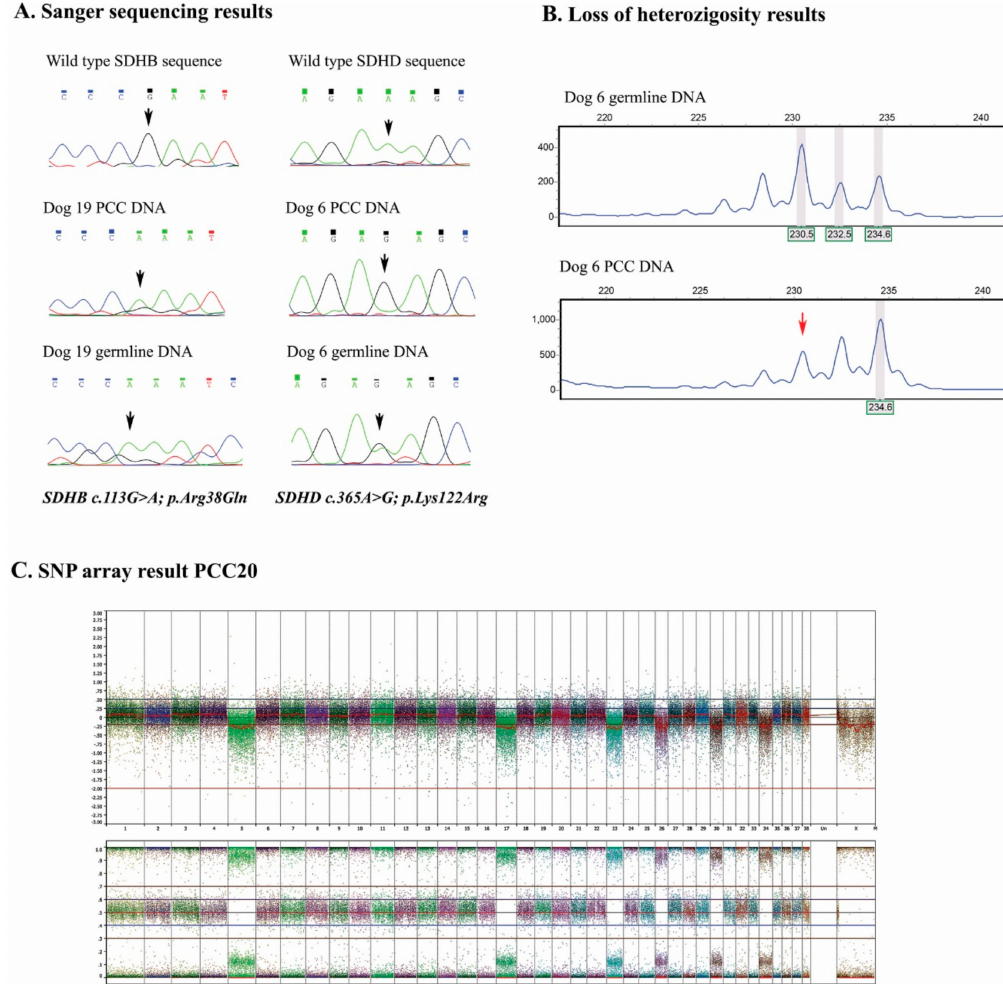
Figure 1. ( A ) In the left panel, succinate dehydrogenase subunit B ( SDHB ) sequences are displayed from healthy reference (upper), PCC19, and corresponding germline DNA. In the right panel, the succinate dehydrogenase subunit D ( SDHD ) sequence is shown from healthy reference, PCC6, and corresponding germline DNA. Note that PCC19 tumor and germline DNA both show the SDHB c.113G > A; p.Arg38Gln variant. PCC6 shows SDHD c.365A > G; p.Lys38Arg in a homozygous fashion in the tumor DNA and heterozygous in the germline DNA, indicating loss of the wild type allele in the tumor. ( B ) Shows loss of heterozygosity of the larger allele in PCC6, confirming the Sanger sequencing results. ( C ) The SNP array result of PCC 20 displays in the upper panel logR ratios, indicating loss of chromosomes 5, 17, 23, 26, 30, and 34. This is also seen in the lower panel by the B-allele